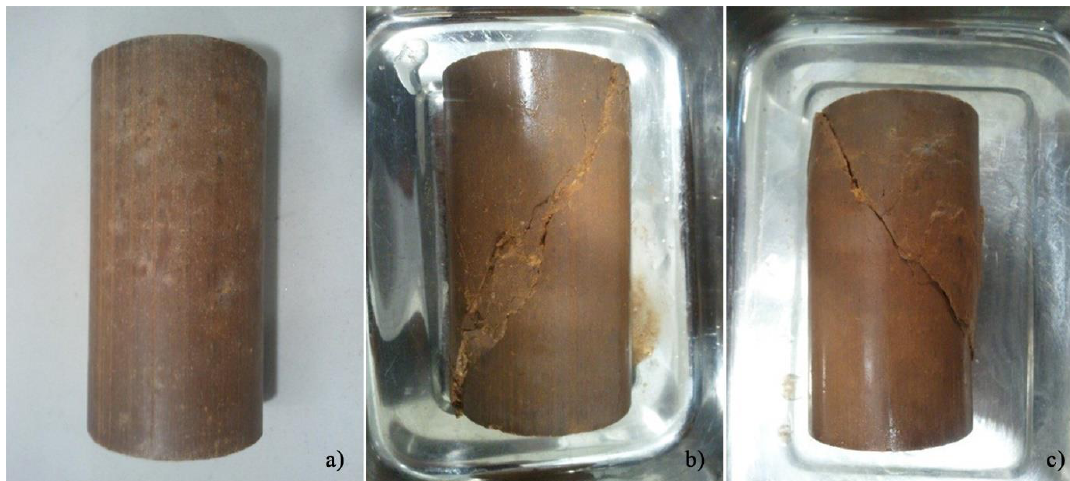
Figure 5. General condition of the OPC-S specimens: ( a ) before testing; ( b ) after testing, with 90 days